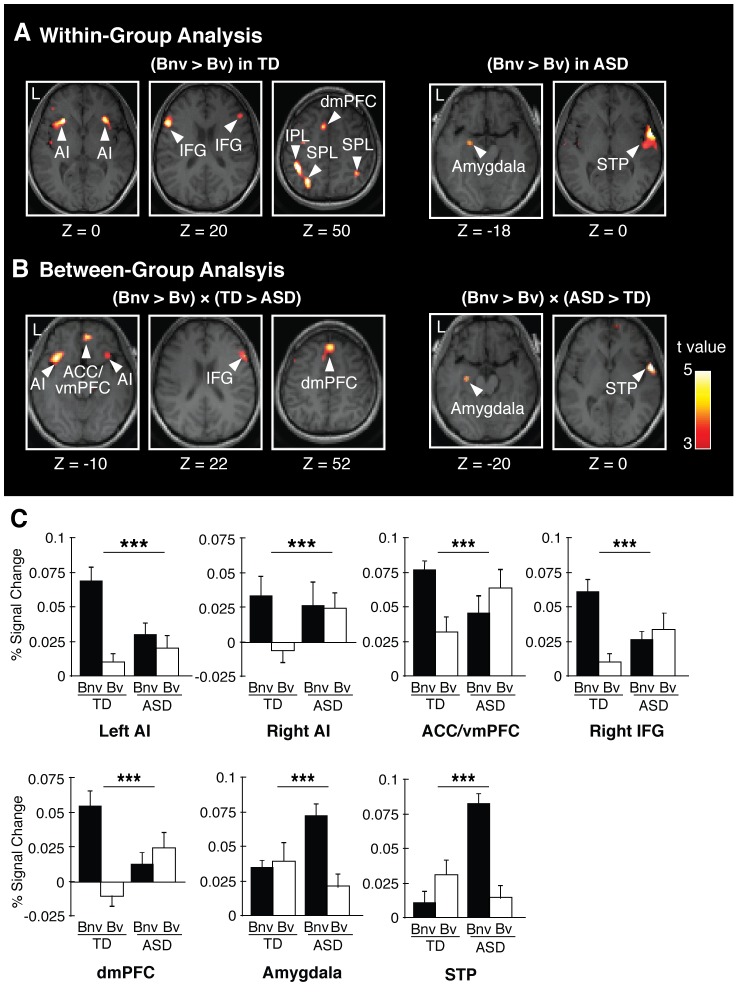
fMRI results (A) Brain regions specific to nonverbal-cue-biased judgments in TD or ASD individuals.The left three panels show the brain regions in which activity was significantly greater during the nonverbal-cue-biased judgments (Bnv) than during the verbal-cue-biased judgments (Bv) in the TD individuals (P<0.05, FDR-corrected). AI: anterior insula, IFG: inferior frontal gyrus, dmPFC: dorsal medial prefrontal cortex, IPL: inferior parietal lobe, SPL: superior parietal lobe. The right two panels show the three brain regions that had significantly greater activity during the nonverbal-cue-biased judgments than during the verbal-cue-biased judgments in the ASD individuals (P<0.05, FDR-corrected). STP: superior temporal pole. (B) Brain regions whose activity was diminished or increased in ASD individuals. The left three panels show the five brain regions that had a significant interaction between the type of judgment and the group, as defined as (Bnv > Bv) × (TD > ASD) (P<0.05, FDR-corrected). That is, in these regions, brain activity specific to the nonverbal-cue-biased judgments was larger in the TD group than in the ASD group. ACC/vmPFC: anterior cingulate cortex/ventral medial prefrontal cortex. The right two panels show the three brain regions in which brain activity specific to the nonverbal-cue-biased judgments was larger in the ASD group than in the TD group (P<0.05, FDR-corrected). (C) Brain activity in the regions showing a significant interaction between judgment and group. The bar graphs show the percent signal changes in the brain regions that were shown in panel (B). ***: P<0.001. error bar: s.d.